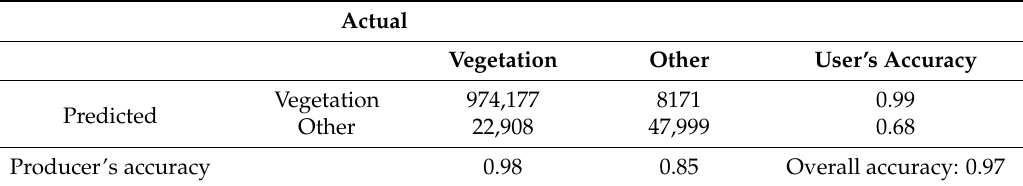
Figure 4. Results of the supervised classification. The green class represents the tall vegetation. The two ‘other’ classes contained data points that were classified as grasslands, agricultural fields, bare soil and water bodies (grey class), or as infrastructure and ditches (blue class). Table 2. Confusion matrix of the predicted against the actual classes.